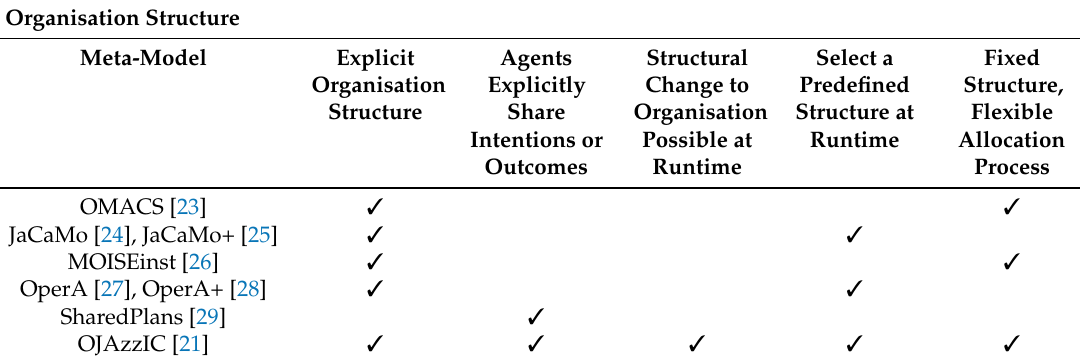
Table 2. Comparing meta-models regarding organisation